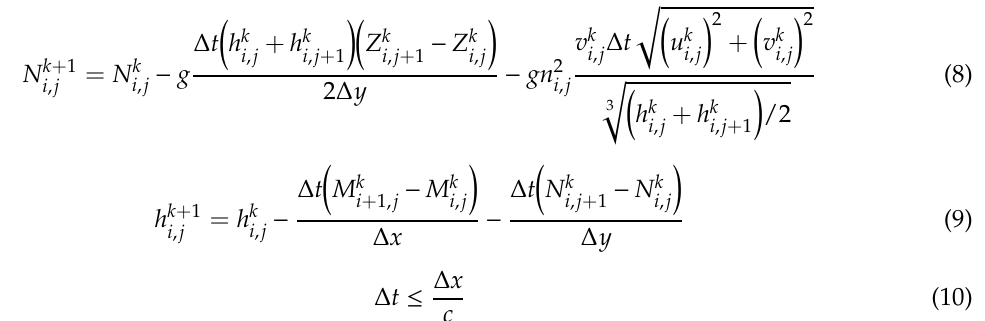
Figure 5. Cellular space difference.